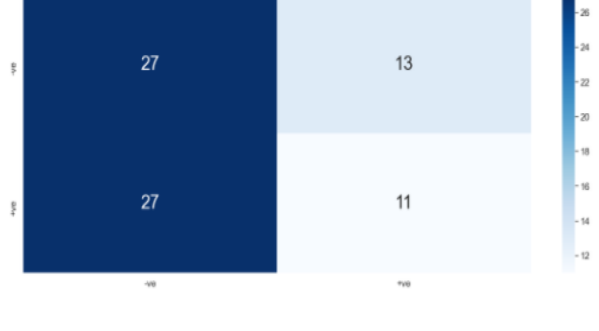
Figure 24. Performance of RF